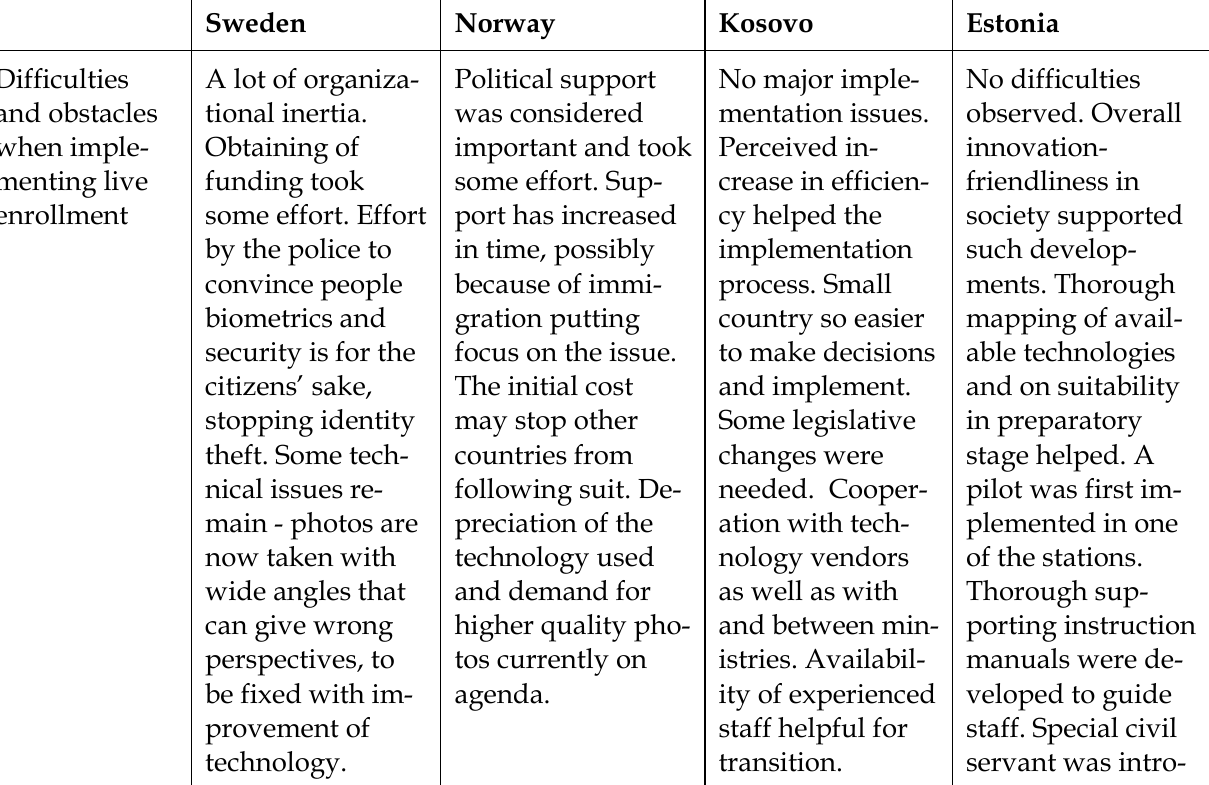
Table 3: Implementation of live enrollment in Sweden, Norway, Kosovo, and